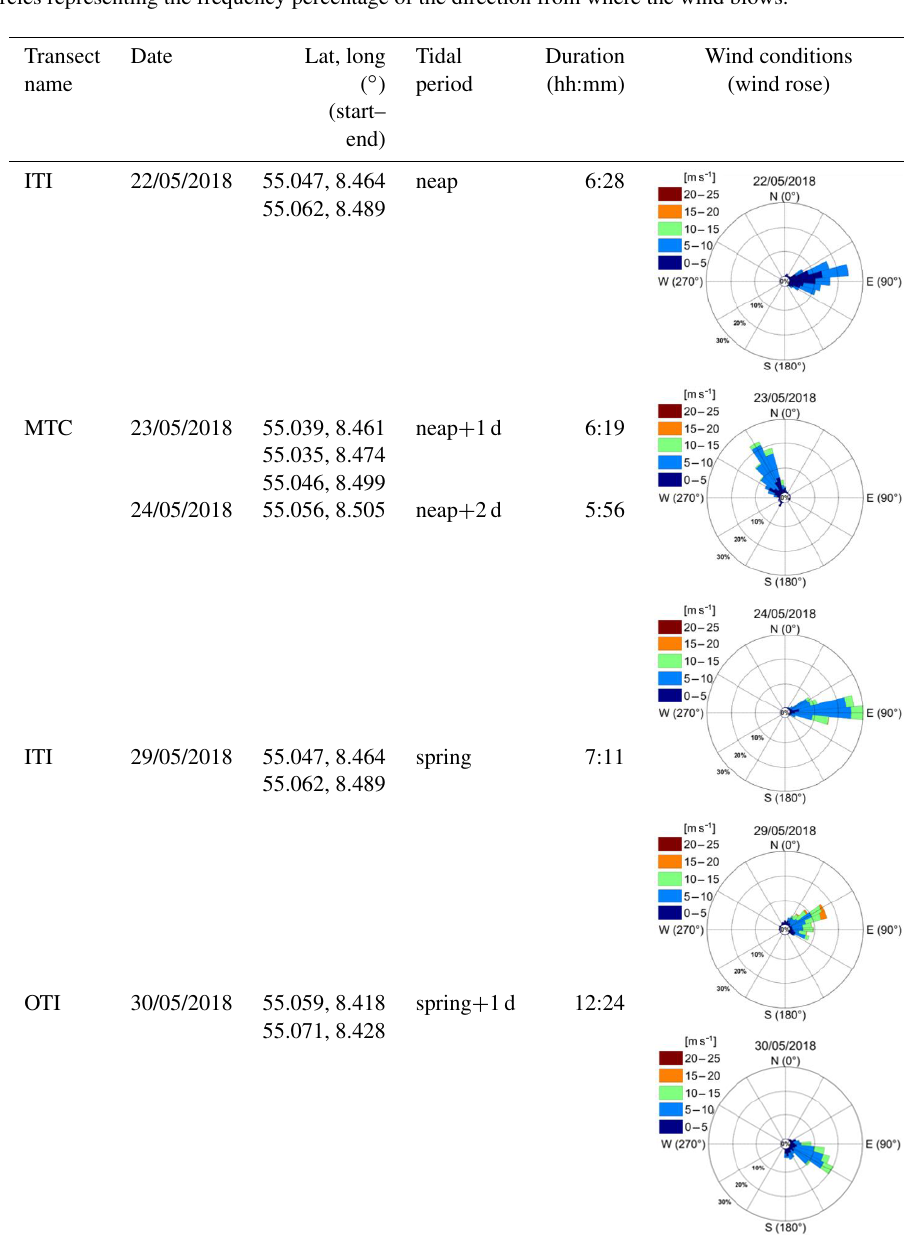
Table A1. Summary of the five cruises on board of RV Mya II , profiling three main transects: inner tidal inlet (ITI), main tidal channels (MTC) and outer tidal inlet (OTI). Main tidal channels (MTC) show the initial, turning and ending points, since it covers three sections in one transect. The wind roses characterize the wind conditions during cruise times, with the legend colours representing the wind velocity (ms − 1 ) and the circles representing the frequency percentage of the direction from where the wind